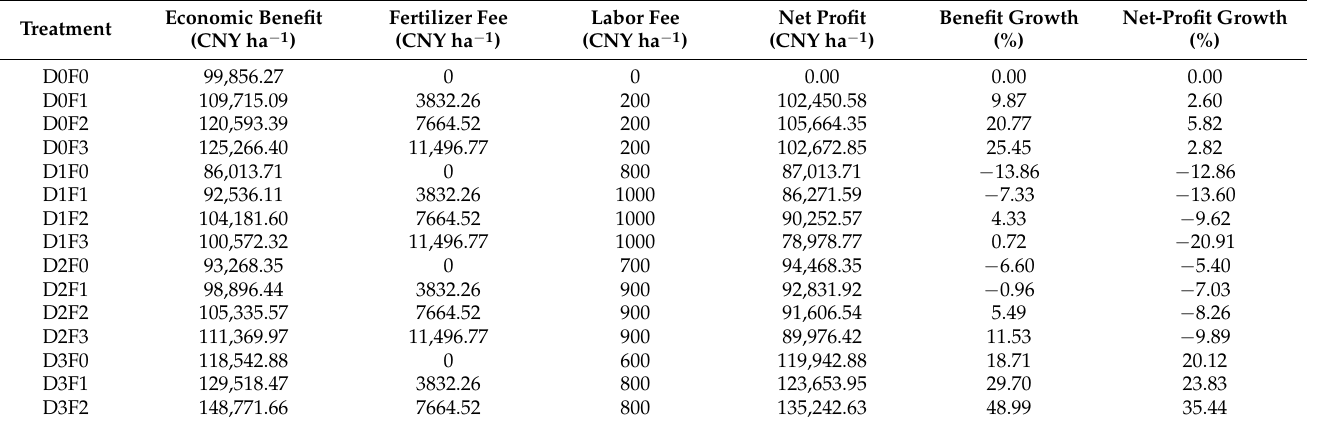
Table A3. Effects of fertilizer and density management on the bamboo shoot economic benefit in bamboo forests (sum of two